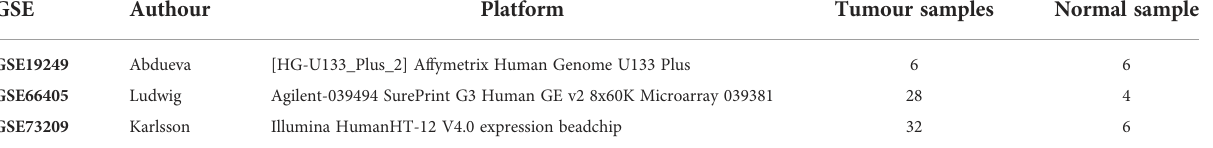
TABLE 1 Details for 3 GEO